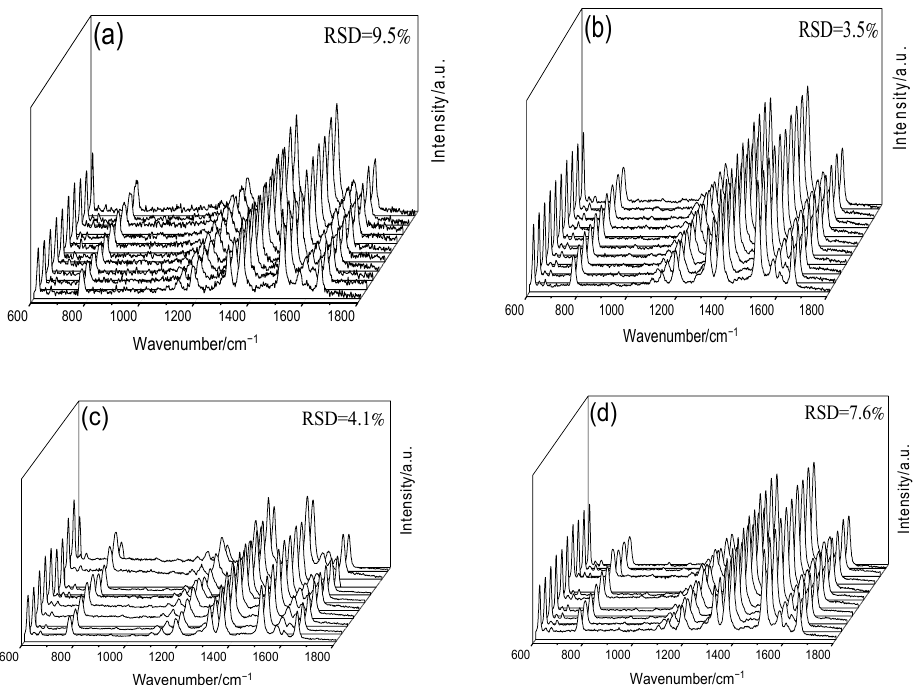
Figure 7. SERS spectra of different concentrations R6G within the range of 600–1800 cm − 1 using AuNPs as the SERS substrate collected from 10 randomly selected spots on the same substrate: ( a ) 0.005, ( b ) 0.05, ( c ) 0.1 and ( d ) 0.5 mM, respectively.